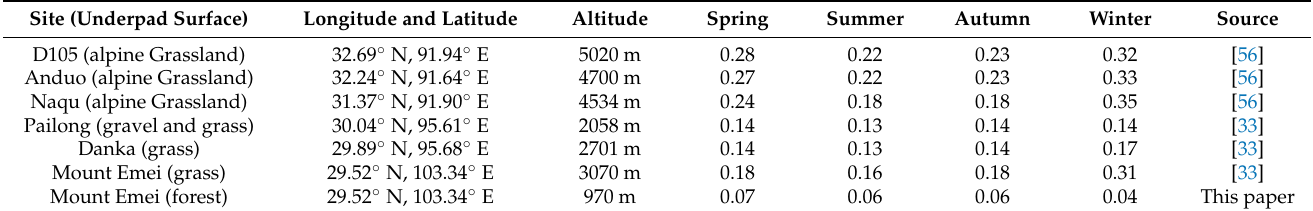
Table 3. Surface reflectance of stations in northern Tibet Plateau and Mount Emei station in each season.